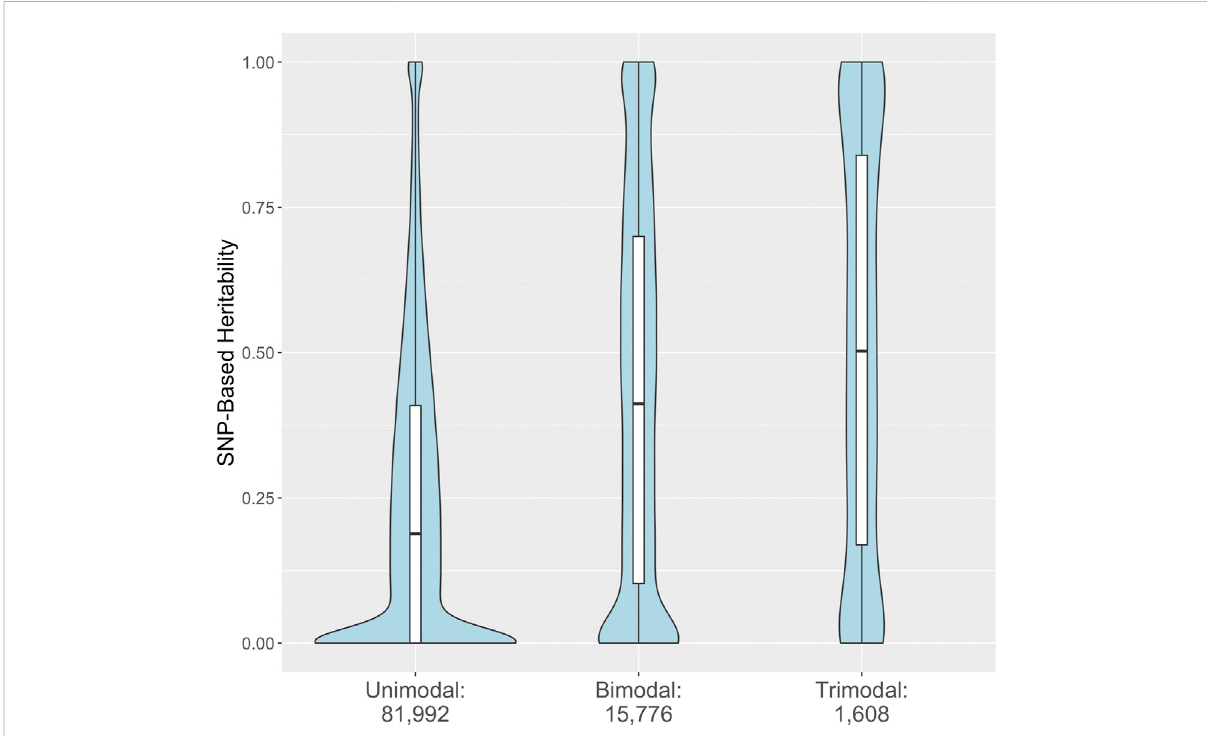
FIGURE 4 Distribution ofSNP-basedheritabilityfor99,376ratbrainRNAtranscripts strati fi edbyestimatedmodality.The SNP-basedheritabilityestimated from strain means and the standard GEMMA model are strati fi ed by the number of modes identi fi ed by fi tting univariate normal mixtures to the RNA expression estimates. The embedded boxplots display the median and interquartile